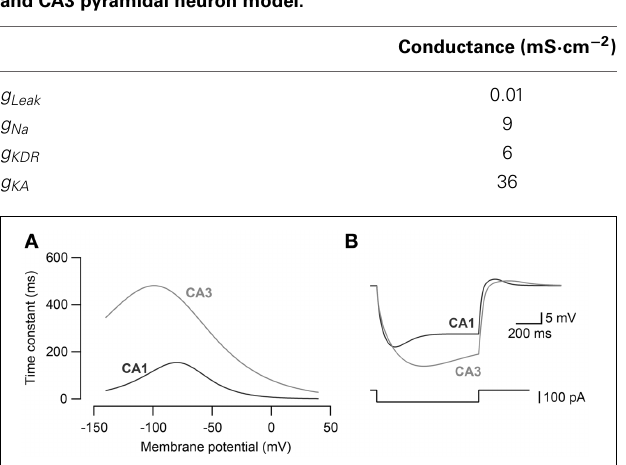
FIGURE 1 | Modeling of I h kinetics. (A) The activation time constants of h-channel conductance for CA3 pyramidal neuron model and CA1 pyramidal neuron model. (B) Voltage response to − 100pA current steps (bottom) in CA3 and CA1 neuron models. CA3 and CA1 neuron models were fit to the voltage response recorded in CA3 and CA1 pyramidal neurons to − 100pA current steps in vitro